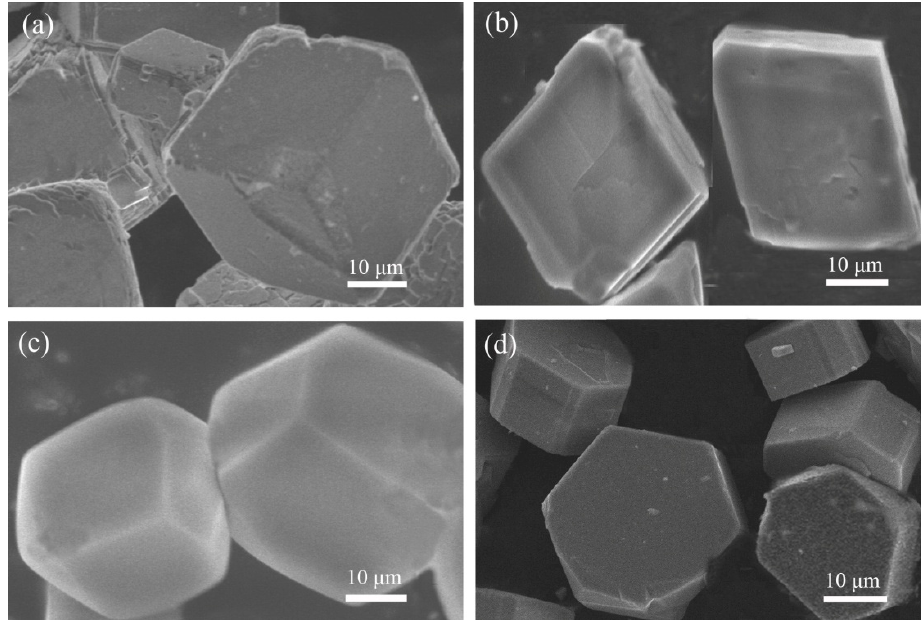
Figure 1. Scanning electron microscopy (SEM) images of compound ( a ) 1 , ( b ) 2 , ( c ) 3 , and ( d ) 4 .